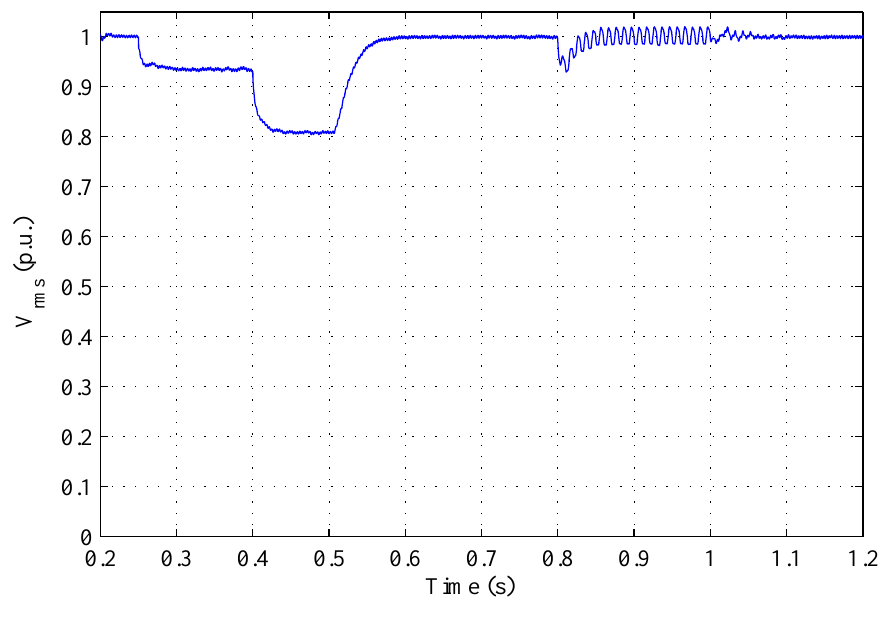
Figure 12. RMS voltage at the